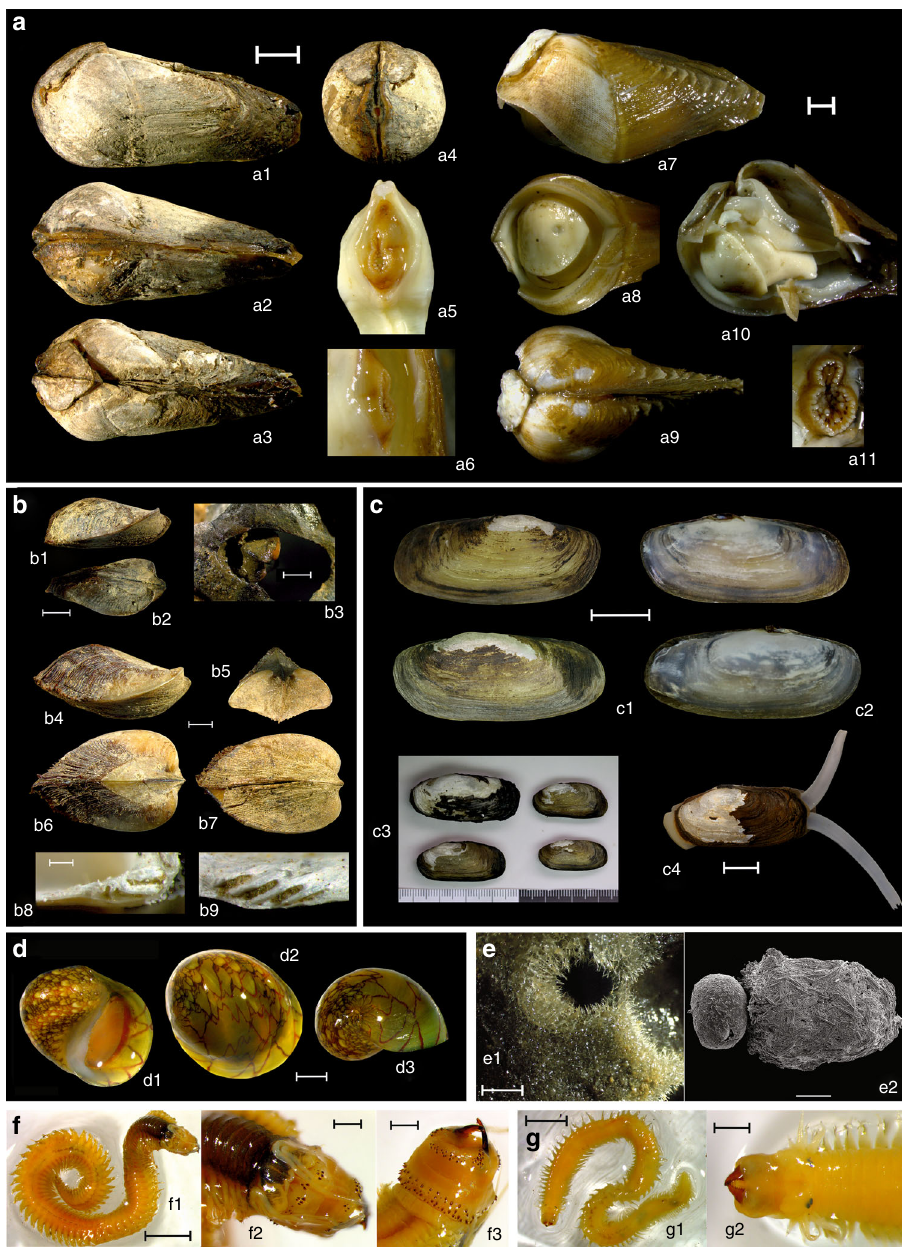
Fig. 4 Rock-boring and nestling macroinvertebrates associated with freshwater bioerosion site at the Kaladan River, western Myanmar. a Lignopholas fl uminalis , a rock-boring species: (a1) Lateral view of an adult specimen with fully developed callum, (a2) Ventral view of apposed valves, (a3) Dorsal view of apposed valves, (a4) Anterior view, (a5) Frontal view of siphons, (a6) Lateral view of siphons, (a7) Lateral view of a young specimen, (a8) Ventral view of the anterior end, (a9) Dorsal view, (a10) Internal morphology of soft body, (a11) Frontal view of siphons (scale bars = 2 mm). b Scaphula deltae , an ark clam species: (b1) Lateral and (b2) dorsal view of a young specimen, (b3) Live clam attached by byssus in borehole, (b4) Lateral and (b5) frontal view of an adult specimen, (b6) Dorsal and (b7) ventral view of an adult specimen, (b8) Cardinal teeth of left valve, (b9) Cardinal teeth of right valve (scale bars = 2 mm). c Novaculina gangetica , a jackknife clam species: (c1) Lateral view of right and left shell valves (outside), (c2) Lateral view of right and left shell valves (inside), (c3) Shell variability, (c4) Live specimen with protruding foot and siphons (scale bars = 10 mm). d Clithon cf. reticularis , a gastropod species: (d1) Apertural view, (d2) Dorsal view, (d3) Apical view (scale bars = 2 mm). ( e ) Corvospongilla ultima , a sponge species: (e1) General view of a sponge body fragment (scale bar = 2 mm), (e2) Three adherent gemmules; gemmular cage covering the left gemmule is removed (scale bar = 500 µ m). f Neanthes meggitti , a polychaete species: (f1) Dorsal view of complete specimen (scale bar = 2 mm), (f2) Dorsal view of the anterior end (scale bar = 0.5 mm), (f3) Ventral view of the anterior end (scale bar = 0.5 mm). g Namalycastis indica , a polychaete species: (g1) Dorsal view of animal (scale bar = 2 mm), (g2) Dorsal view of the anterior end (scale bar = 0.5 mm). (Photos: Olga V. Aksenova [ a , b , d , e1, f , and g ], Ekaterina S. Konopleva and Ilya V. Vikhrev [ c ], and Agniya M. Sokolova